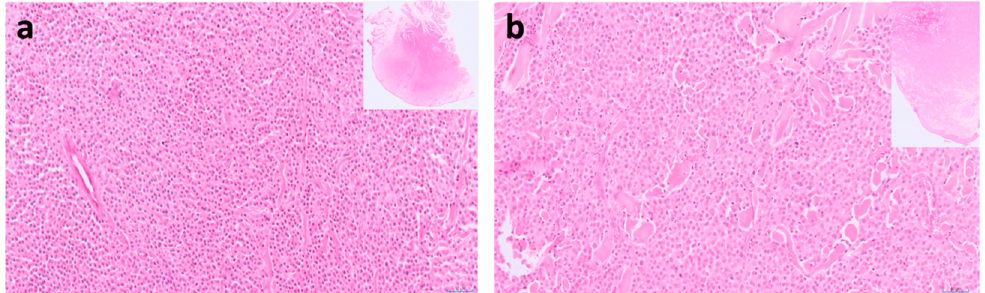
Figure 5. Two cases of feline cutaneous mast cell tumour. ( a ) Microscopic image of a well-differen- tiated mastocytic subtype of feline cutaneous mast cell tumour, in a 7-year old, male Burmese cat. The mitotic count was 3 per 10 HPFs (400×; 2.37mm 2 ). HE-stained, ×20 magnification (inset is low- power view). The long-term clinical outcome was reported as good, with a follow-up period of 1838 days. ( b ) Microscopic images of a well-differentiated mastocytic subtype of feline cutaneous mast cell tumour, in an 8-year old, male Domestic short hair cat. The mitotic count was 2 per 10 HPFs (400×; 2.37 mm 2 ). HE-stained, ×20 magnification (inset is low-power view). The overall the survival time was 598 days, with clinical outcome reported as suspected metastatic spread (not histologically confirmed) involving the skin and the spleen. Critically, these cases show great similarity in histo- logical appearance, but their outcomes were vastly different.